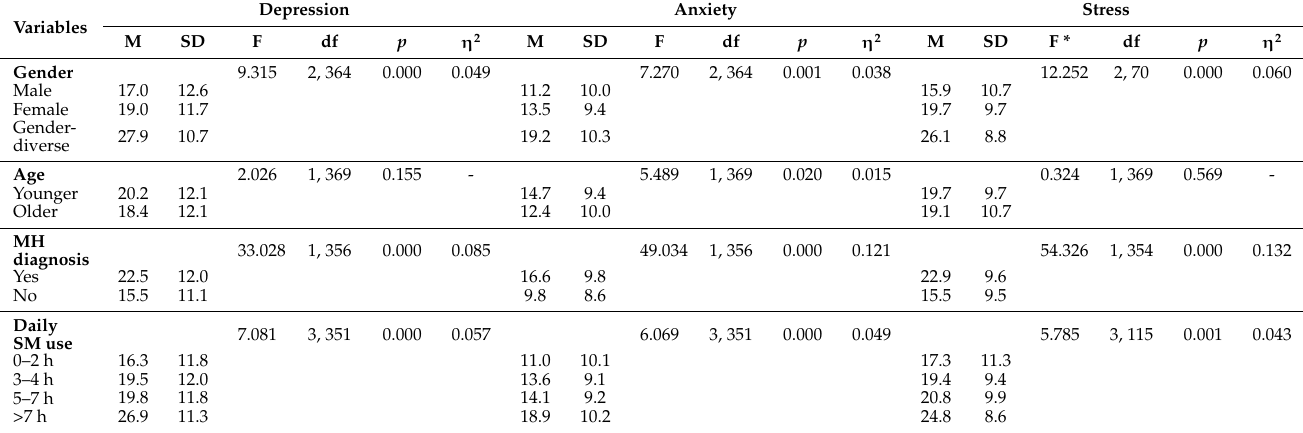
Table 4. One-way ANOVAs exploring the relationship between DASS-21 subscale scores and gender, age, diagnosis, and social media use.